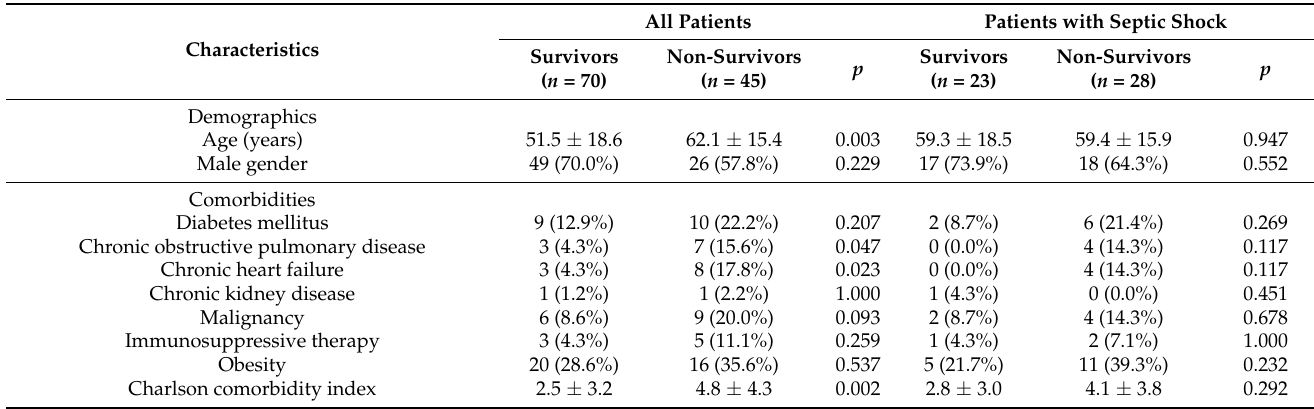
Table 1. Univariate analyses of predictors of 30-day mortality in patients with pandrug-resistant Klebsiella pneumoniae (PDR-Kp) bloodstream-infection (BSI) during intensive care unit (ICU) stay.